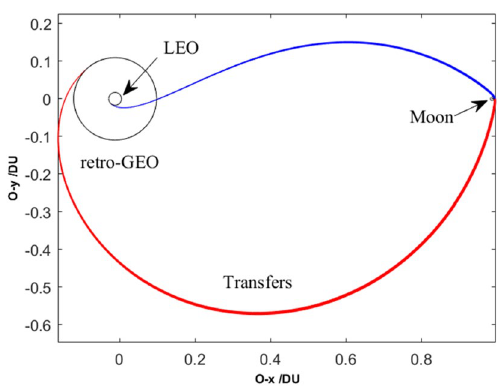
Figure 5. The planar trajectories of the transfers.